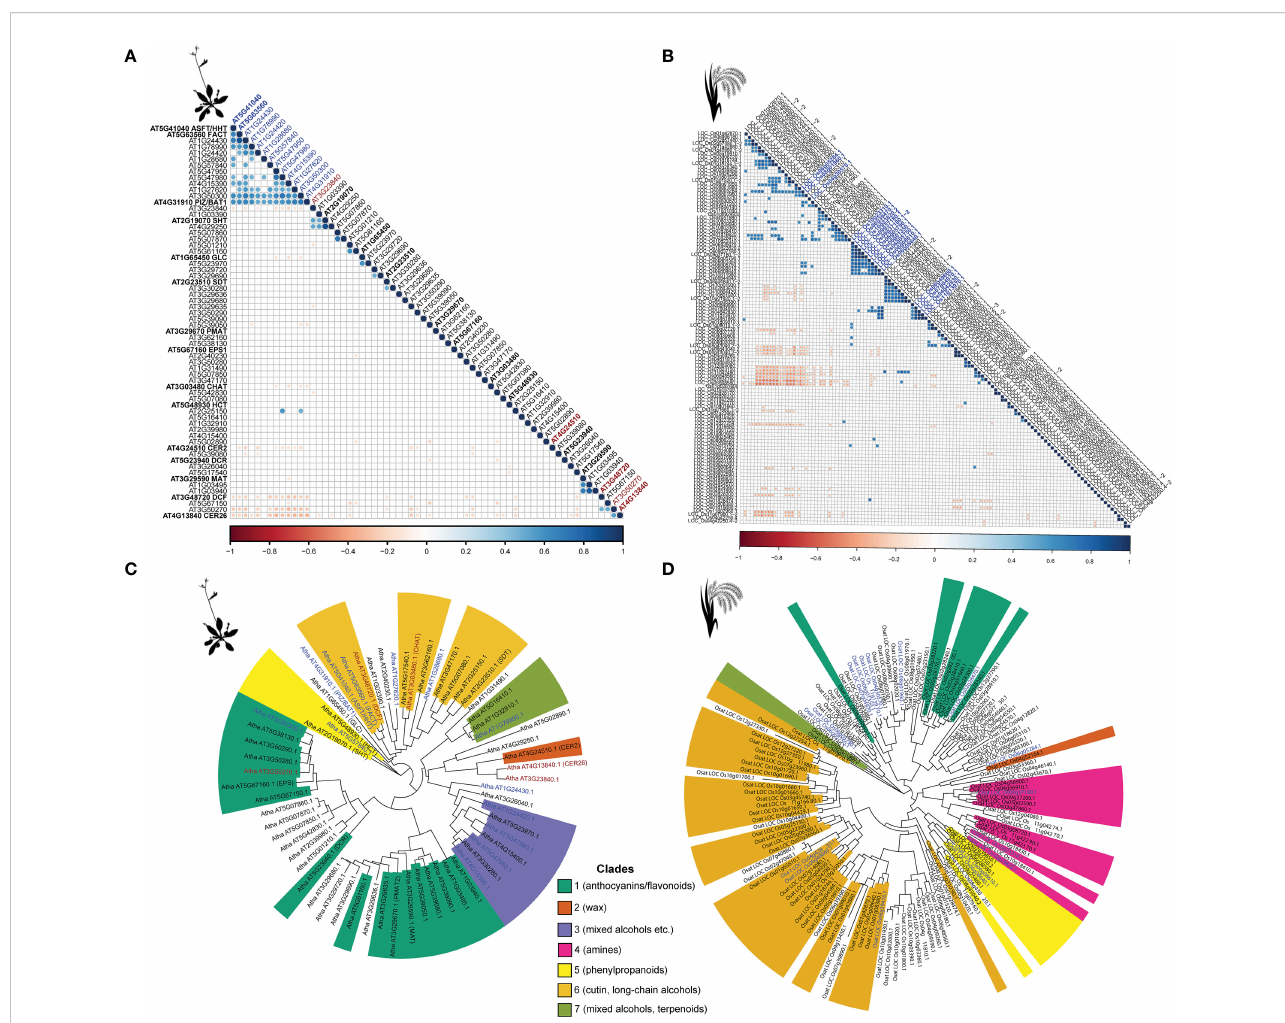
FIGURE 4 Co-expression of BAHDs in rice and Arabidopsis. (A) Co-expression matrix of Arabidopsis BAHDs. (B) Co-expression matrix of rice BAHDS. (C) Maximum- likelihood tree of Arabidopsis BAHDs. (D) Maximum-likelihood tree of rice BAHDS. Trees were inferred using IQTREE with 1000 bootstrap replicates and different colors represent different clades that were mapped using BLASTP (see Methods). Blue colored sequences were found to be positively coexpressed (PCC >= 95th percentile) and sequences colored in red are strongly negatively correlated (PCC <= 5th percentile). Sequences highlighted in bold in (A) have functional annotations. Clade nomenclature corresponds to the nomenclature introduced in Kruse et al., 2022 and typical substrate classes (but not all) are noted for each